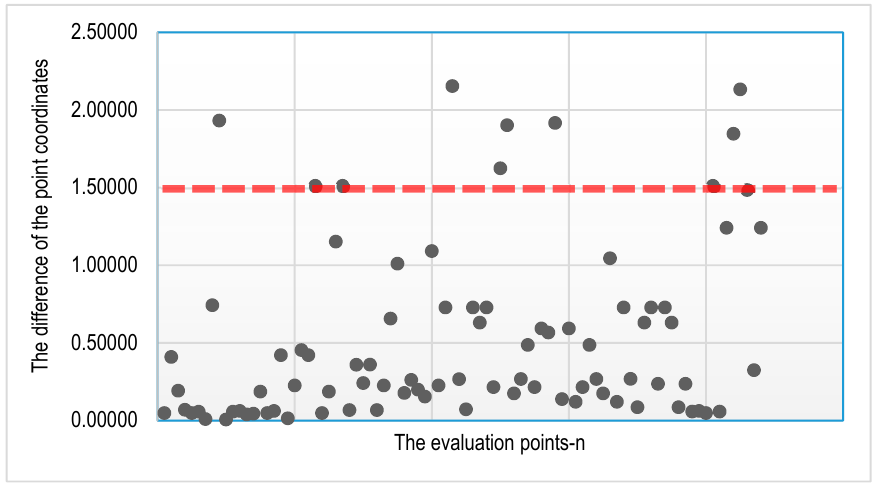
Figure 2. Positional accuracy (in meters) plotted as shifting of points found between reference and evaluation dataset, shifting > 1.5 m is indicated through the red dashed line.